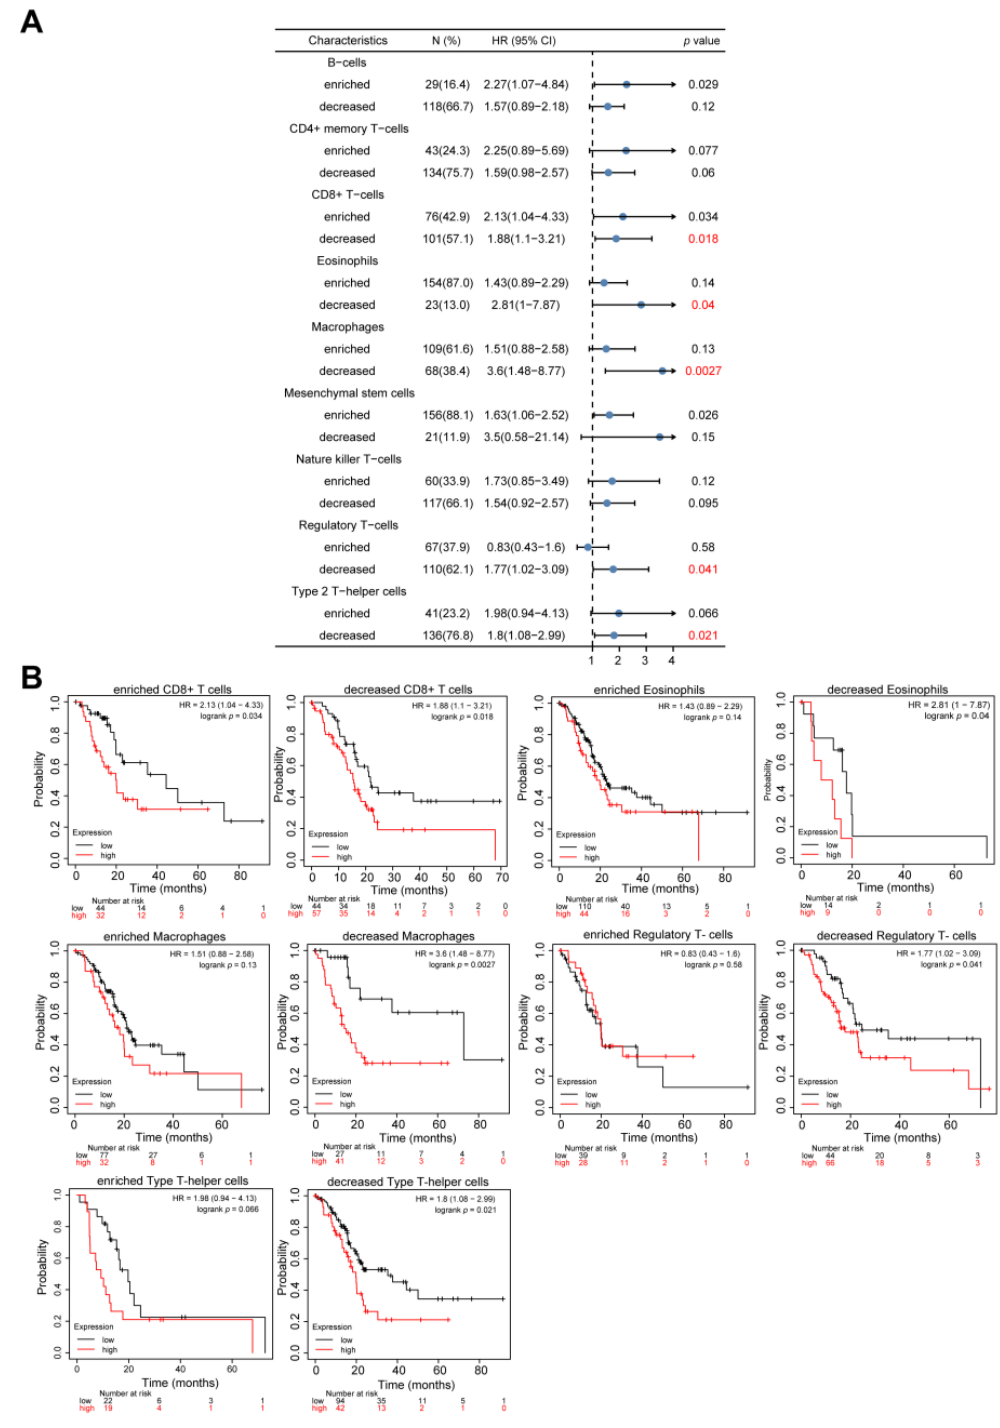
Figure 9. Kaplan–Meier survival curve of high and low expression of STAU2 in pancreatic cancer- immune cell subsets. ( A ) Forest plot showing the prognostic value of STAU2 expression in different subsets of immune cells in PAAD patients. ( B ) The Kaplan–Meier plotter method was used to demonstrate the correlation between STAU2 expression and OS in different subsets of immune cells from PAAD patients.